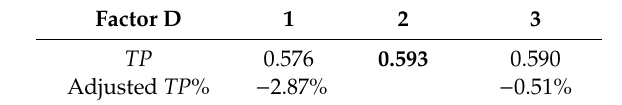
Table 5. The values for the TP and the adjusted TP % resulting from a change in factor D. Factor D 1 2 3 TP 0.576 0.593